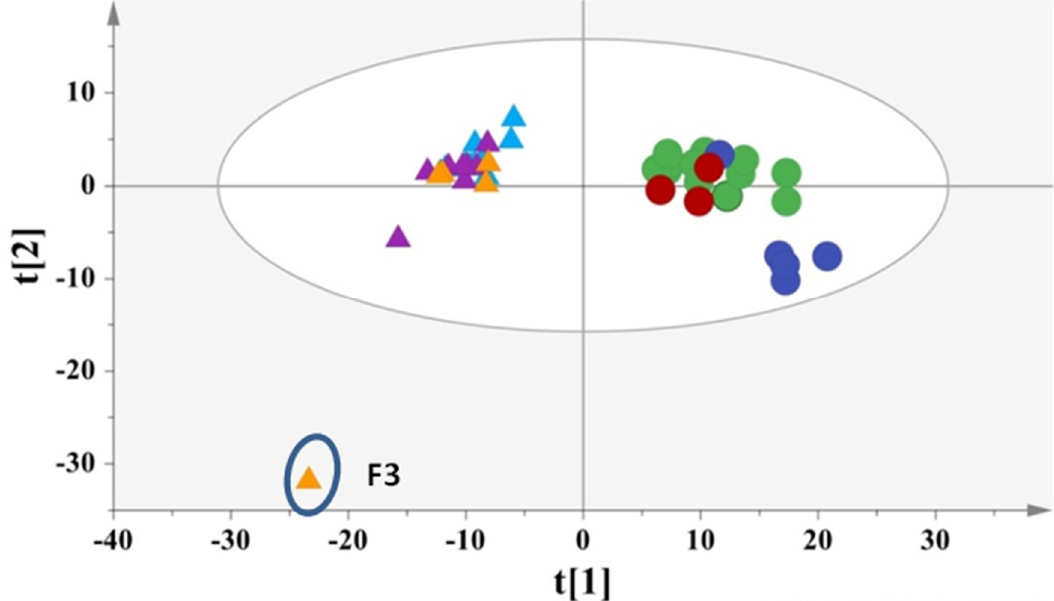
Figure 2. PCA, N = 43, R 2 X(cum)= 0.94, Q 2 (cum)= 0.87 (Circles = balsamic vinegars, Triangles = common vinegars, green = red balsamic vinegars with honey, blue = red balsamic vinegars, red = white balsamic vinegars, turquoise = red common vinegars, purple = white common vinegars, orange = common vinegars from fruits, F3 = common vinegar with Sea Buckthorn).